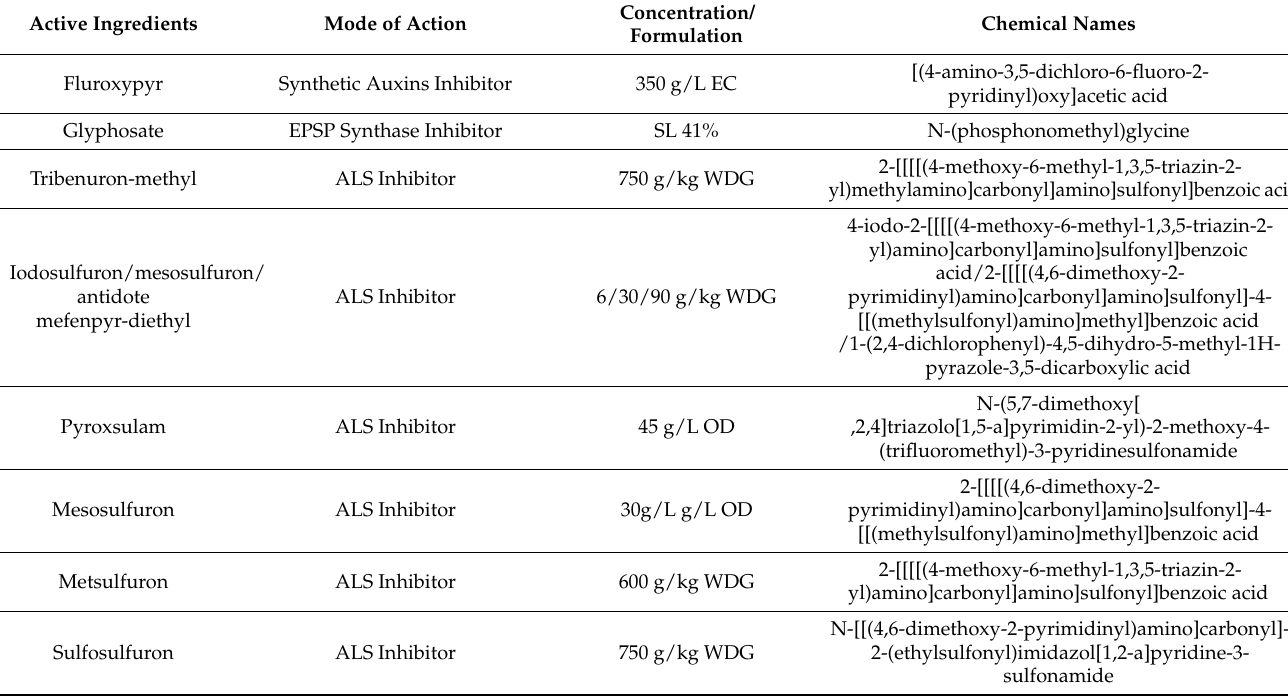
Table 1. List of herbicides and their rates, mode of action and chemical